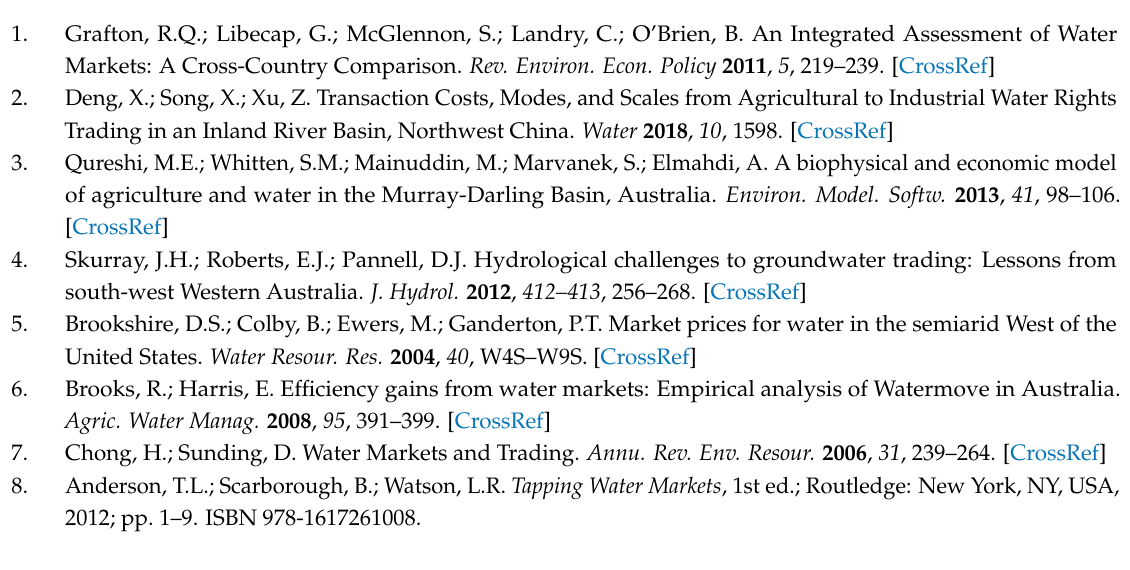
Table S1: Deflated water transfer prices by Duration and Transfer-direction, 1987–2010 (per Committed Acre-foot), Table S2: Deflated water transfer prices by State and Duration, 1987–2010 (per Committed